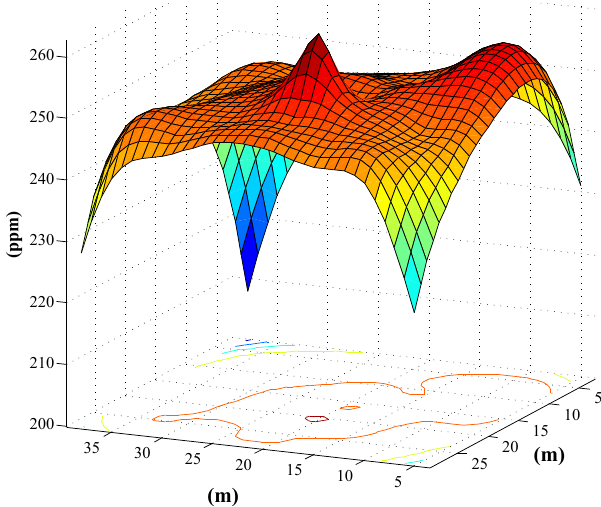
Figure 9. Predicted based on Gaussian Process